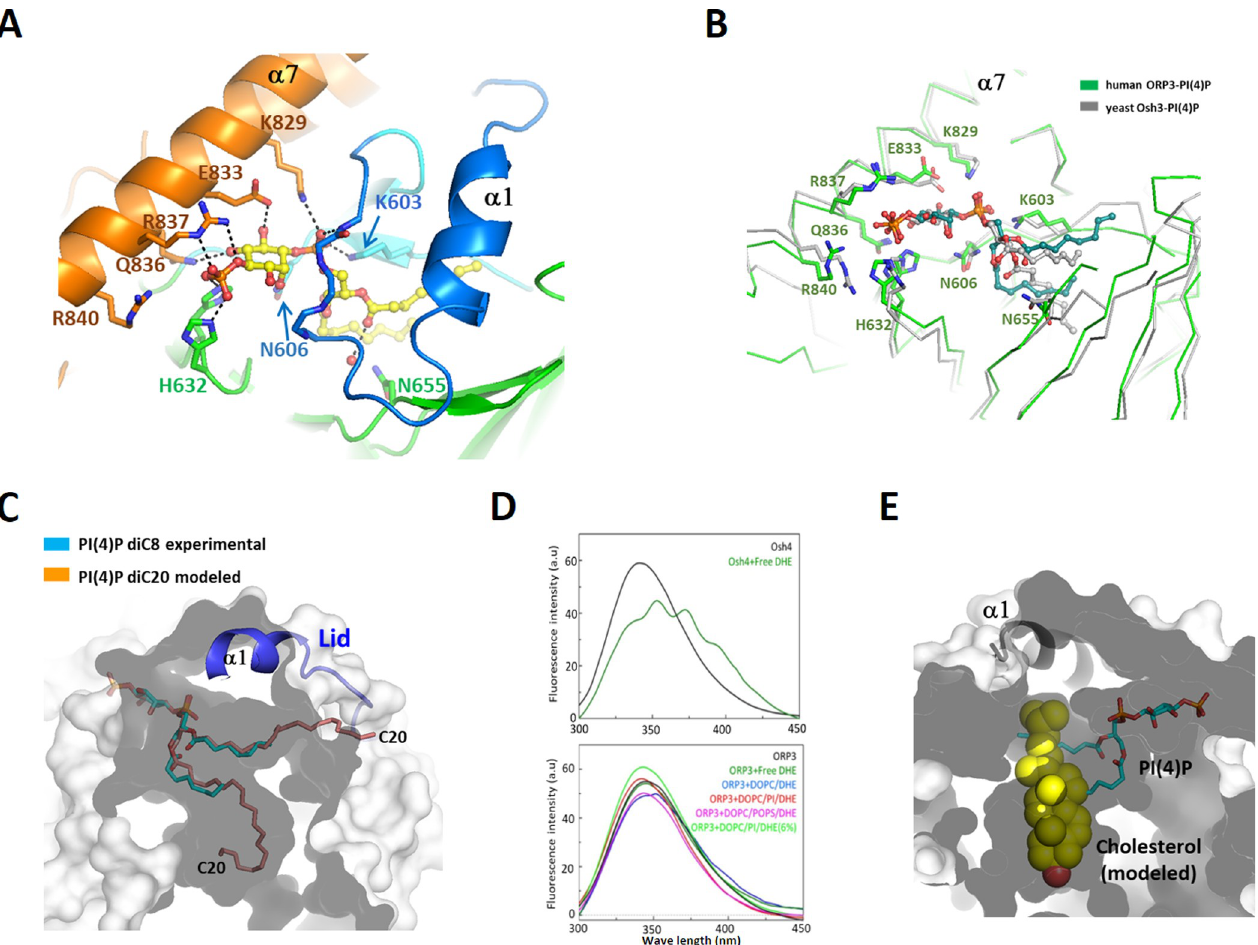
Fig 3. PI(4)P-binding to the ORP3 ORD. (A) Binding of PI(4)P diC8 in the ORP3 ORD. The residues interacting with the PI(4)P head group are shown in stick models. Hydrogen bonds with PI(4)P are shown in dotted lines. (B) Structure comparison of the PI(4)P-binding sites of human ORP3 and yeast Osh3. (C) Modeling suggested that PI(4)P diC20 can be accommodated in the binding pocket of ORP3. The acryl chains of PI(4)P diC8 were extended to diC20 and were manually fitted into the pocket. The shape of the ligand-binding pocket is shown as a transparent surface. The surface representation was sliced to visualize the interior of the ORP3 molecule. The outer and inner surfaces of ORP3 were shown in light grey and dark grey, respectively. (D) Dehydroergosterol (DHE) binding of Osh4 and ORP3. Fluorescence emission spectra (excitation wavelength λ ex = 285 nm) of the ORD domains incubated with the various liposomes containing DHE. DOPC/DHE (98:2 mol/mol), DOPC/PI/DHE (97.5:0.5:2), or DOPC/POPS/DHE (88:10:2). (E) Cholesterol cannot fit into the hydrophobic tunnel of the ORP3 ORD. The PI(4)P in the binding pocket is shown in a stick model. The cholesterol molecule was modeled into the pocket by superposing the structures of ORP3 and cholesterol-bound ORP1 (PDB id: 5ZM5). The cholesterol atoms clashing with the wall of the hydrophobic pocket are shown in light yellow.